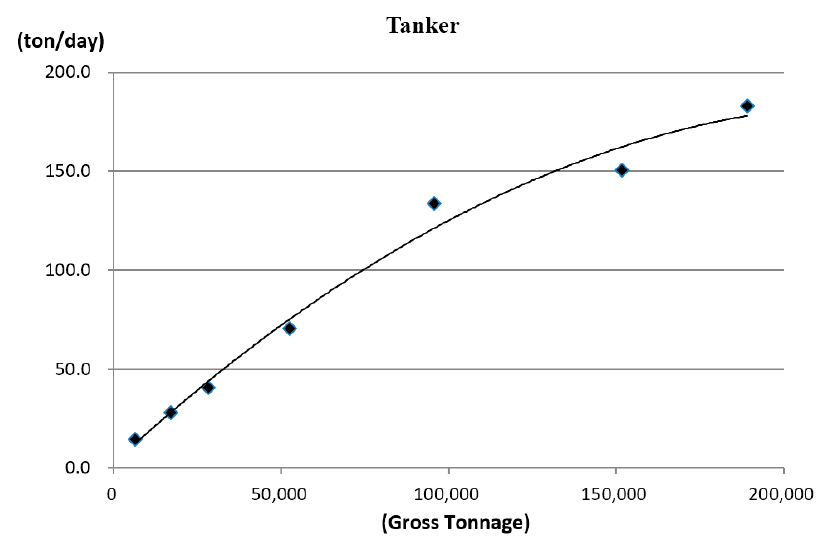
Figure 4. Daily LNG Fuel Consumption of Tanker.